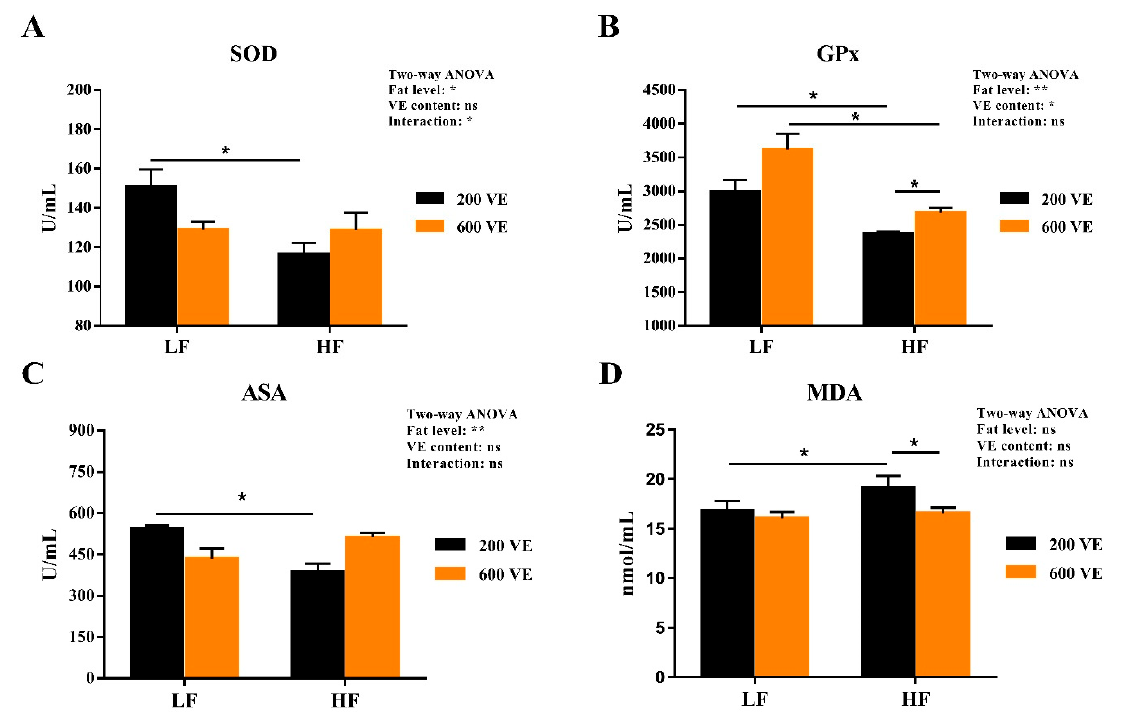
Figure 5. Hemolymph oxidative status of Macrobrachium rosenbergii fed with different dietary fat and VE levels. ( A ) hemolymph superoxide dismutase (SOD) activity of M. rosenbergii fed with different dietary fat and VE levels; ( B ) hemolymph glutathione peroxidase (GPx) activity of M. rosenbergii fed with different dietary fat and VE levels; ( C ) hemolymph anti-superoxide anion (ASA) activity of M. rosenbergii fed with different dietary fat and VE levels; ( D ) hemolymph malonaldehyde (MDA) content of M. rosenbergii fed with different dietary fat and VE levels. Values are means ± SEM. ***: p < 0.001, **: p < 0.01, *: p < 0.05, ns: p < 0.05.